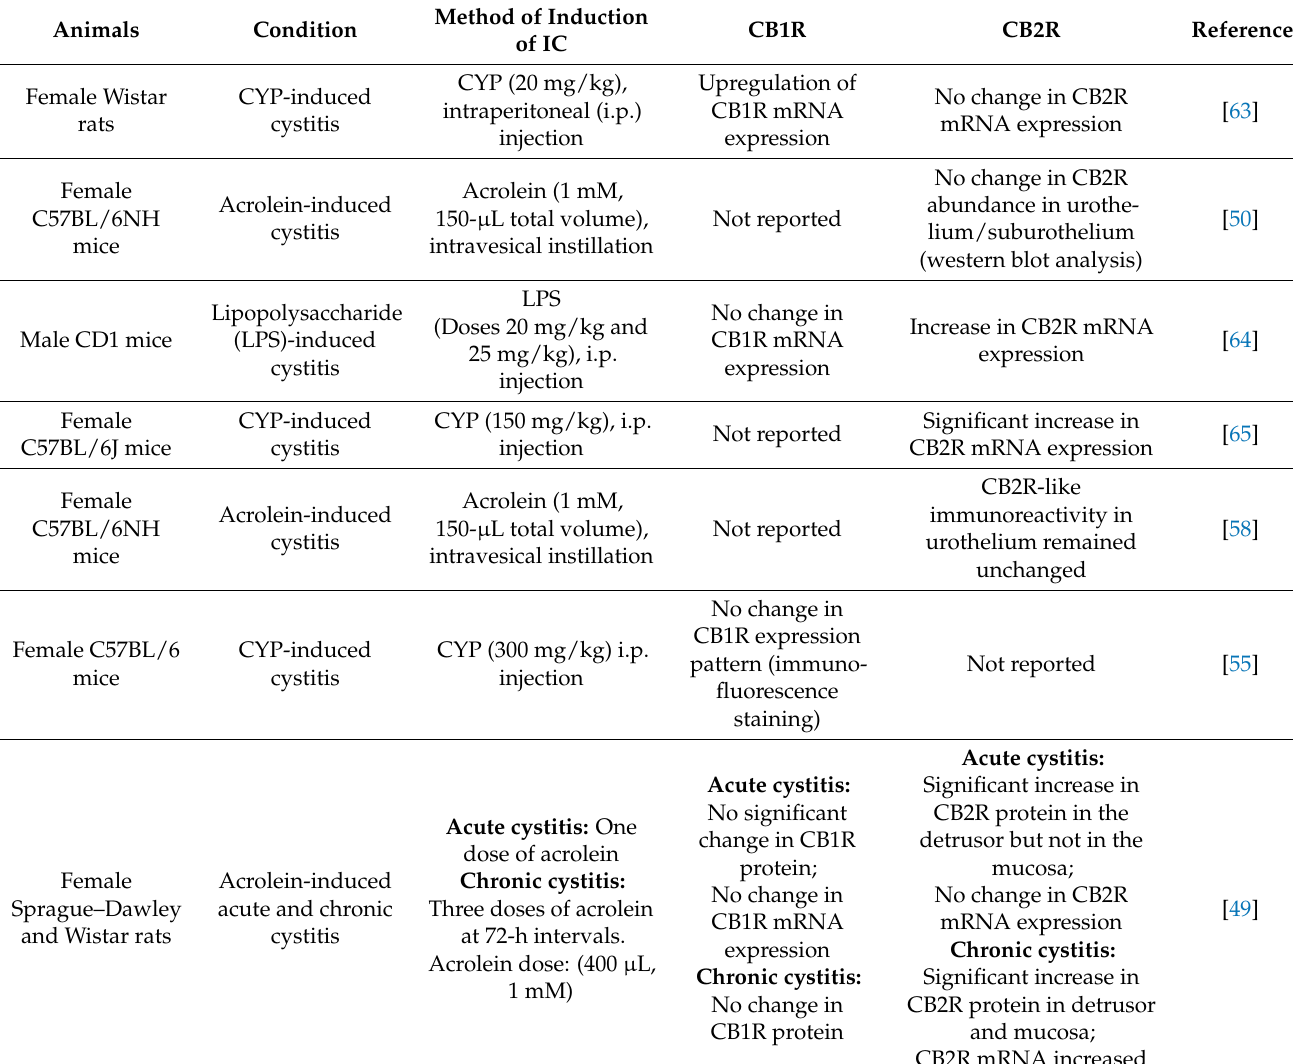
Table 1. Endocannabinoid Receptor Expression in the Bladder Tissue of Experimental IC/BPS